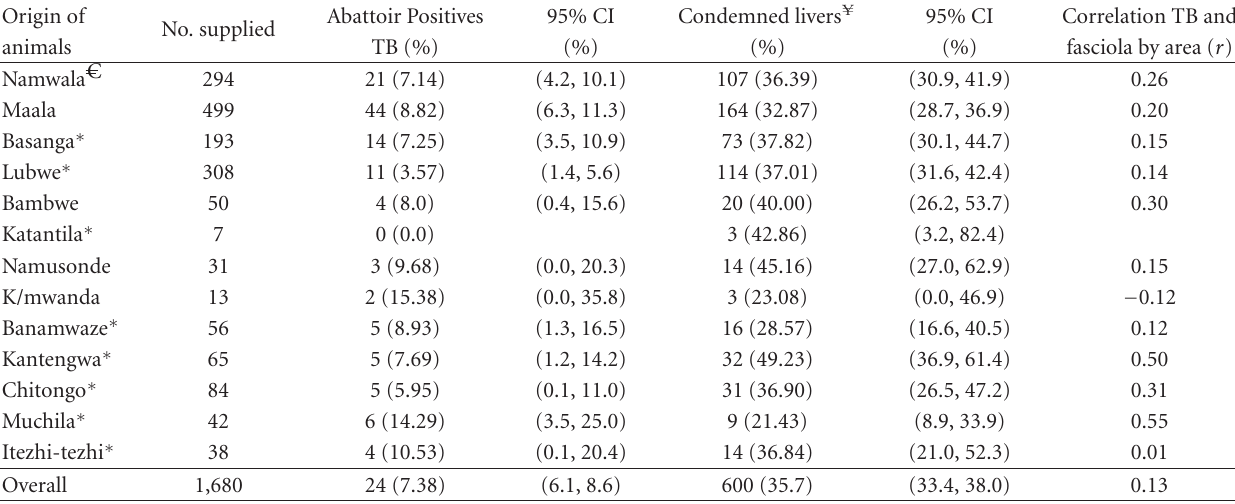
Table 1: Proportion estimates and linear correlation of tuberculosis and fasciolosis positives based on abattoir survey by area of origin ( n = 1,680, February to June of 2008) in